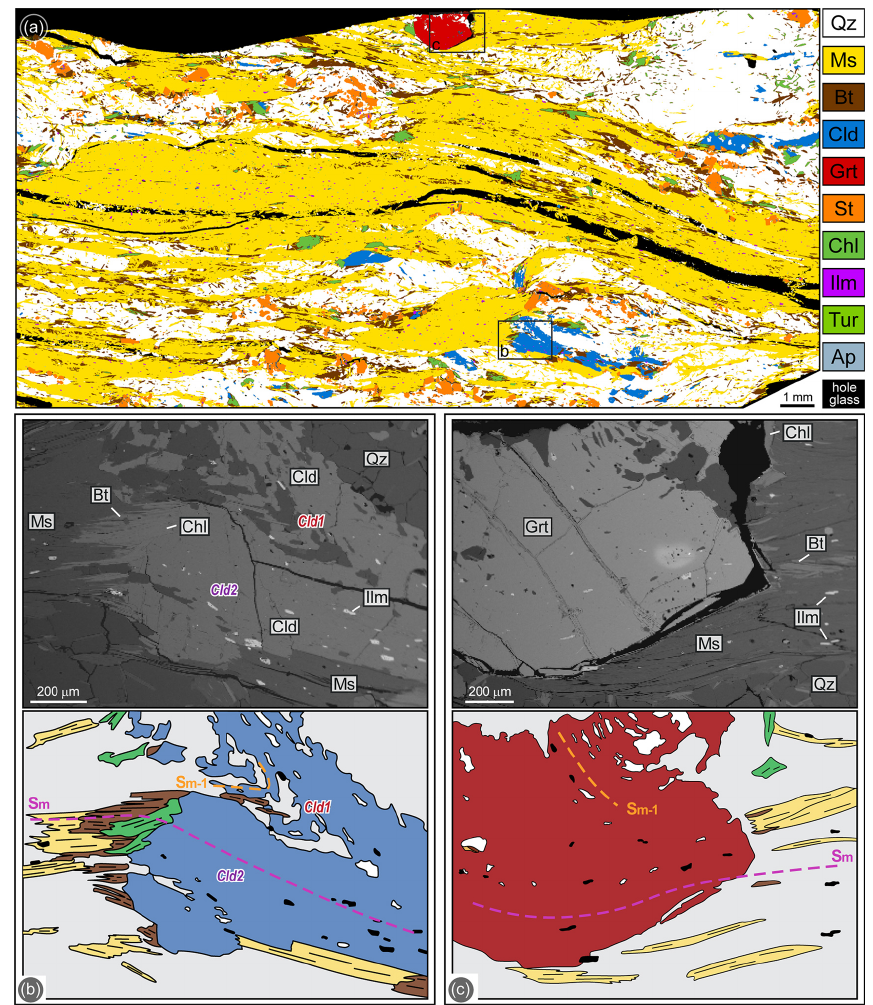
Figure 2. (a) Processed high-resolution multispectral map of sample 19a-2a. (b) Chloritoid porphyroblast preserving an internal Sm − 1 foliation in the core (Cld1) and an internal Sm foliation parallel to the external one (Cld2), supporting its multistadial growth. Chlorite grows statically on the Sm, replacing both chloritoid and biotite (back-scattered electron image, BSE, and redrawn sketch of the microphotograph). (c) Garnet porphyroblast showing an internal foliation parallel to the external Sm, while preserving an inclusion trail discordant with the Sm interpreted as Sm − 1 (BSE image and redrawn sketch of the microphotograph). The grey matrix in the redrawn sketches in (b) and (c) mostly consists of